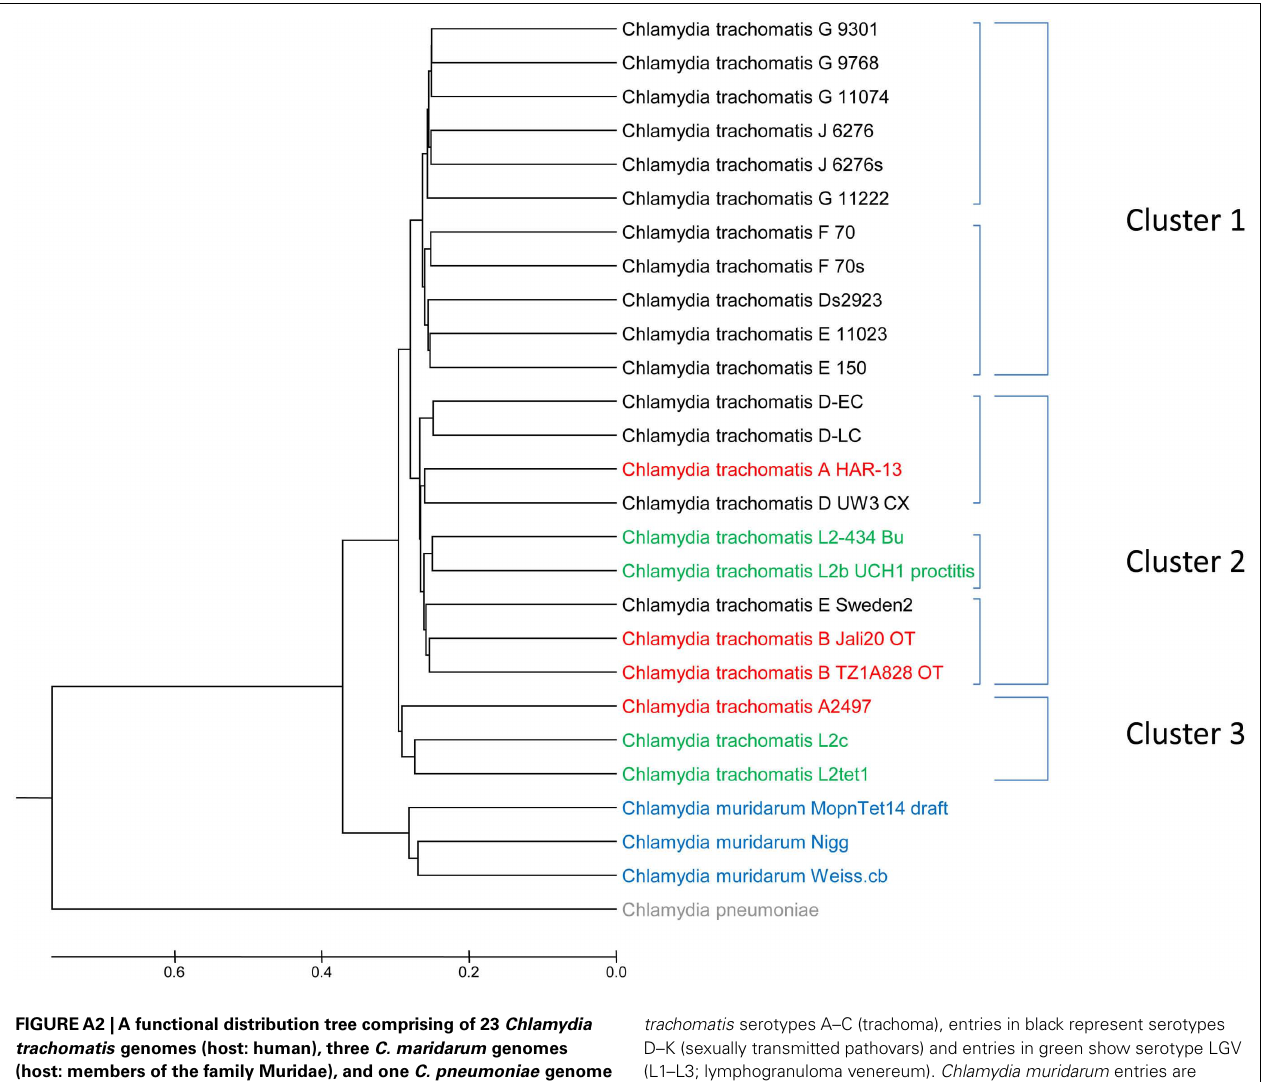
FIGUREA2 |A functional distribution tree comprising of 23 Chlamydia trachomatis genomes (host: human), three C. maridarum genomes (host: members of the family Muridae), and one C. pneumoniae genome were used to investigate genome similarities and the FGD-power-of-resolution on strain level. Entries in red depict Chlamydia